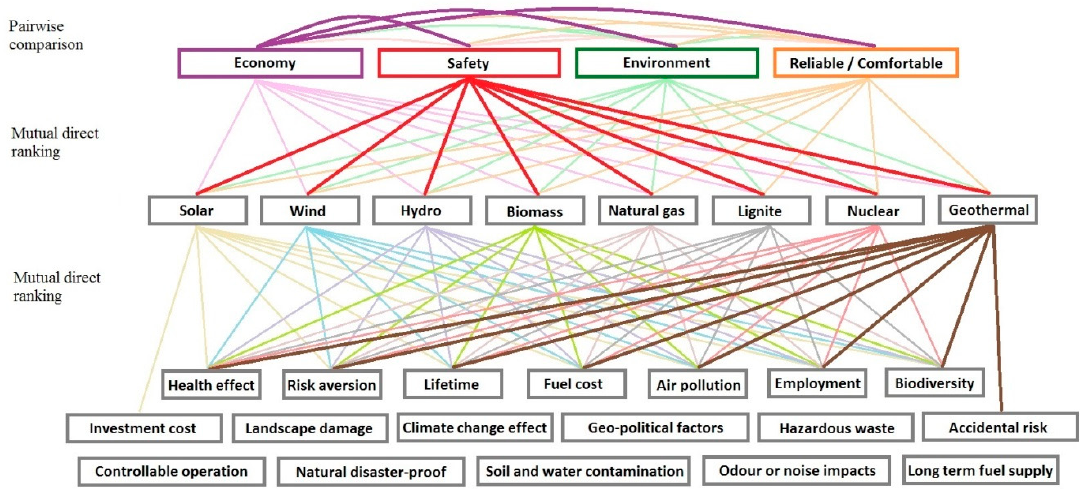
Figure 3. The structure and comparisons of the analytic network process (ANP) method applied for the evaluation.